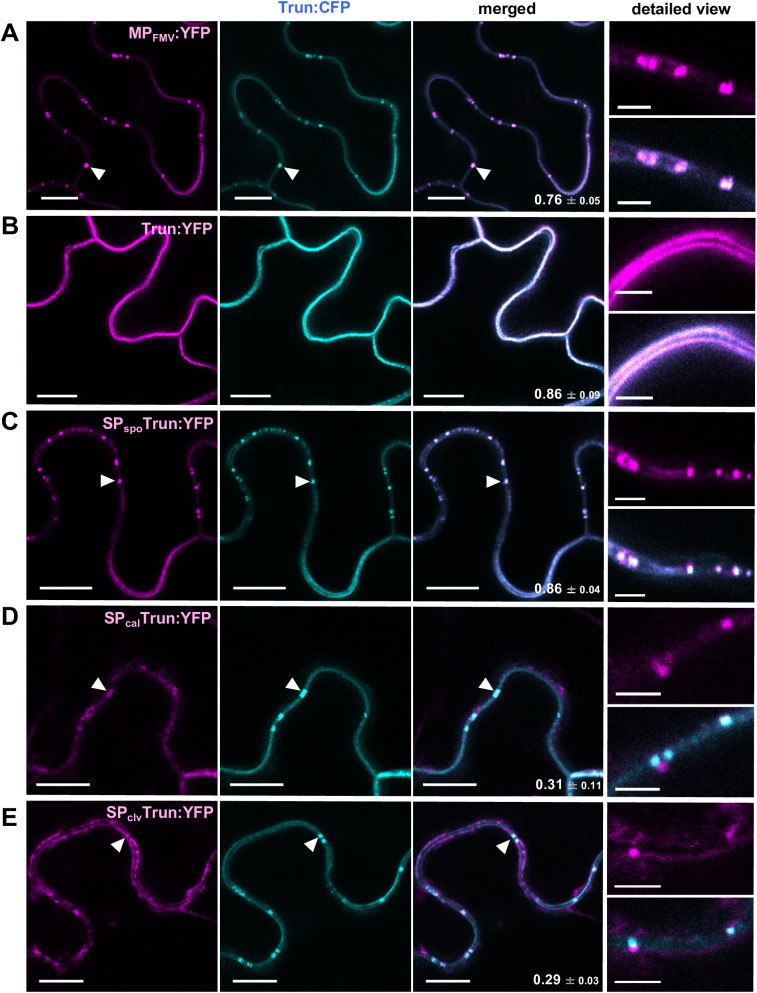
SP-deficient MPFMV localizes to PD when co-expressed with MPFMV or SP chimeras.Trun:CFP was co-expressed with (A) MPFMV:YFP, (B) Trun:YFP, (C) SPspoTrun:YFP, (D) SPcalTrun:YFP or (E) SPclvTrun:YFP. Cells were observed at 36 hpi. YFP fluorescence was pseudocolored with magenta. Arrowheads indicate localization to PD. Bars in images of detailed view are 2.5 μm. The others are 10 μm.